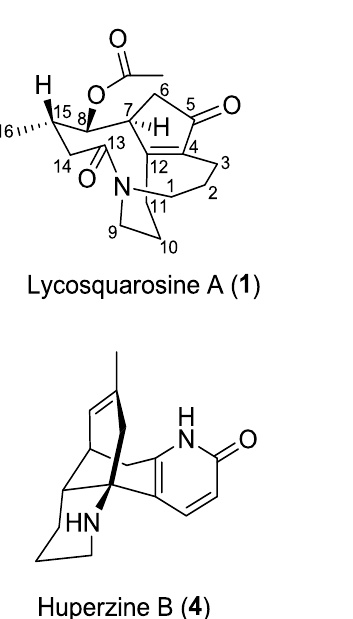
Figure 1. Chemical structures of isolated compounds 1 – 6